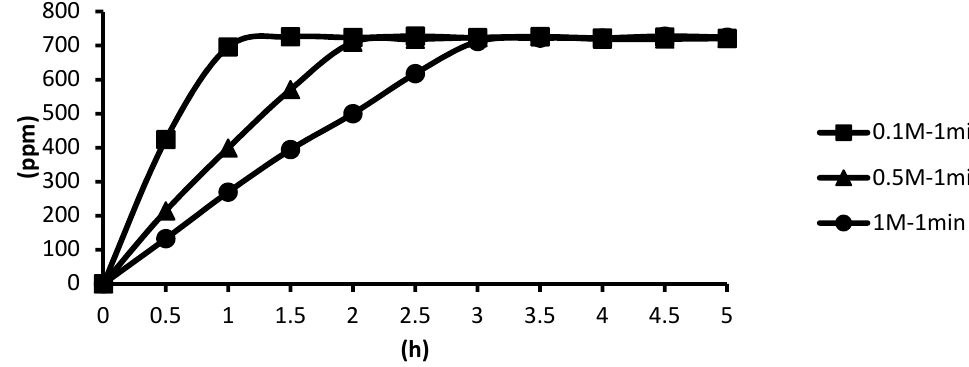
Figure 21. The effect of ZnCl 2 concentration (cross-linking time of one minute) on releasing of tea tree essential oil from alginate/tea tree essential oil microcapsules in the hot spring water.